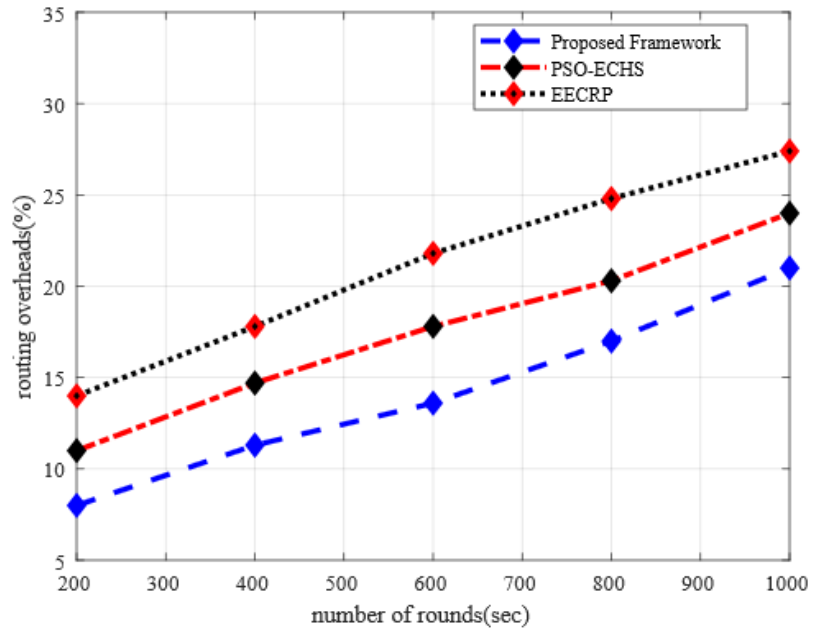
Figure 7. The impact of simulation rounds on routing overheads.